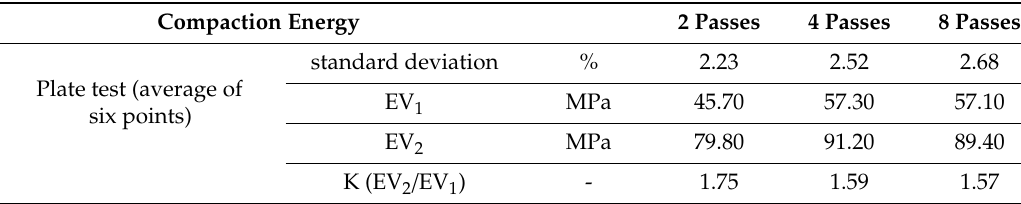
Table 6. Results of lift tests.